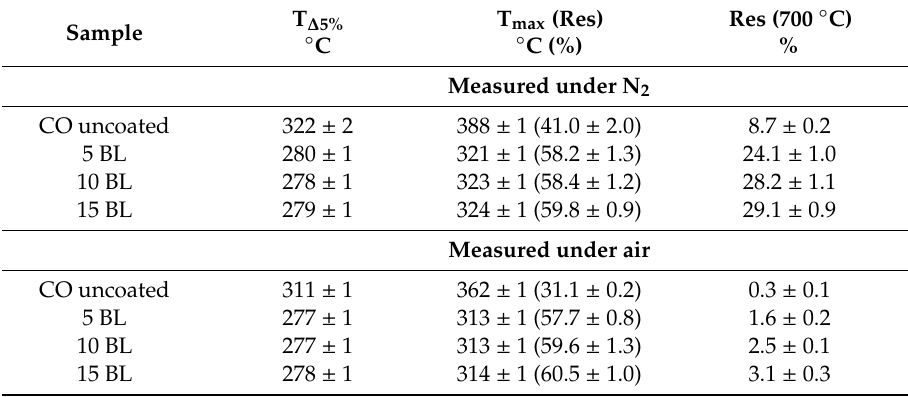
Table 2. Thermogravimetric analysis data, measured under nitrogen and